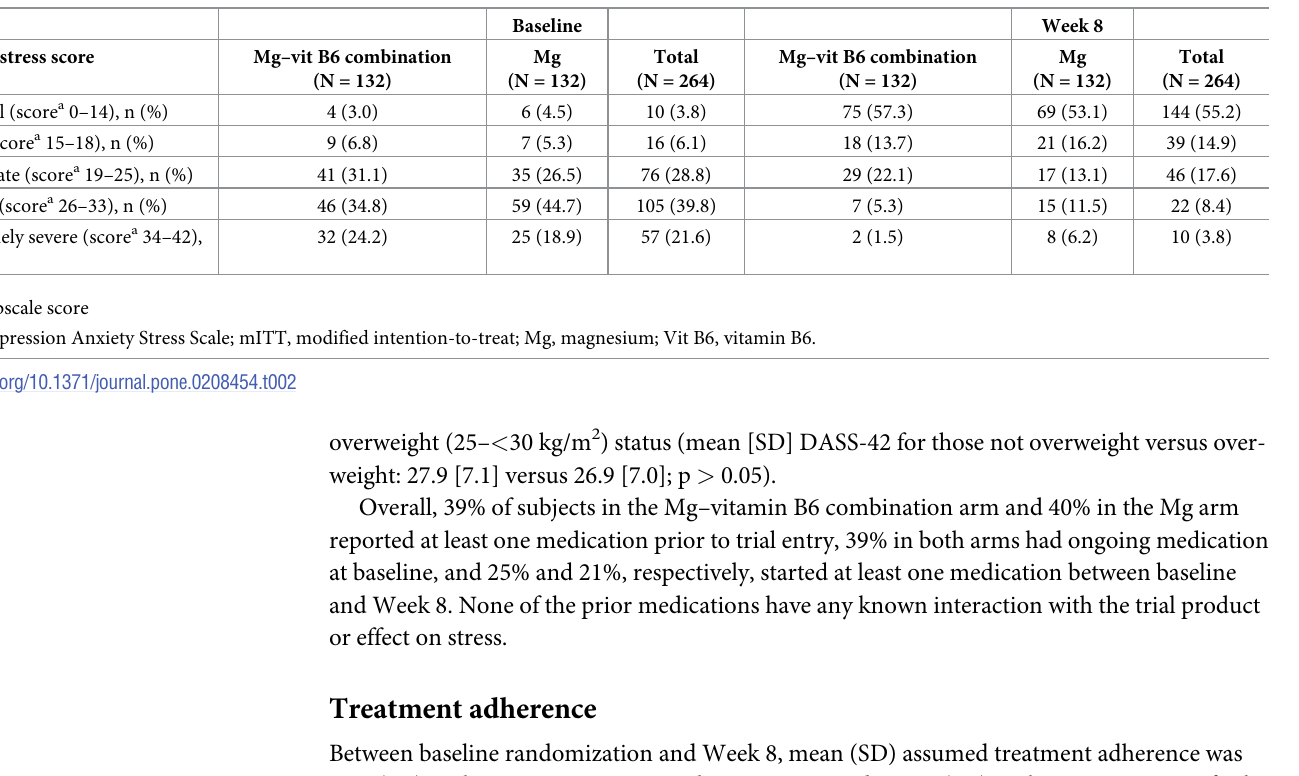
Table 2. Distribution of DASS-42 stress subscale scores at baseline and Week 8 (mITT